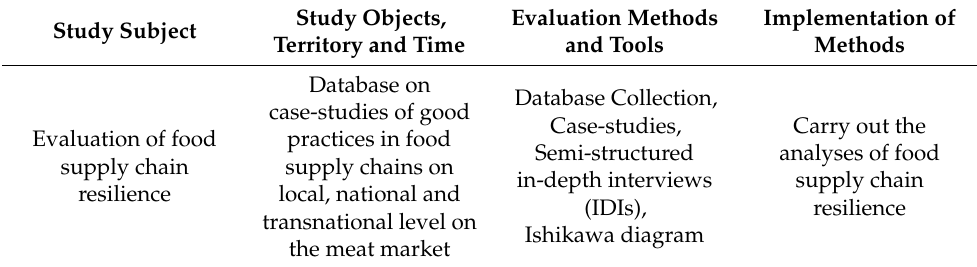
Table 1. Characteristics of the study.